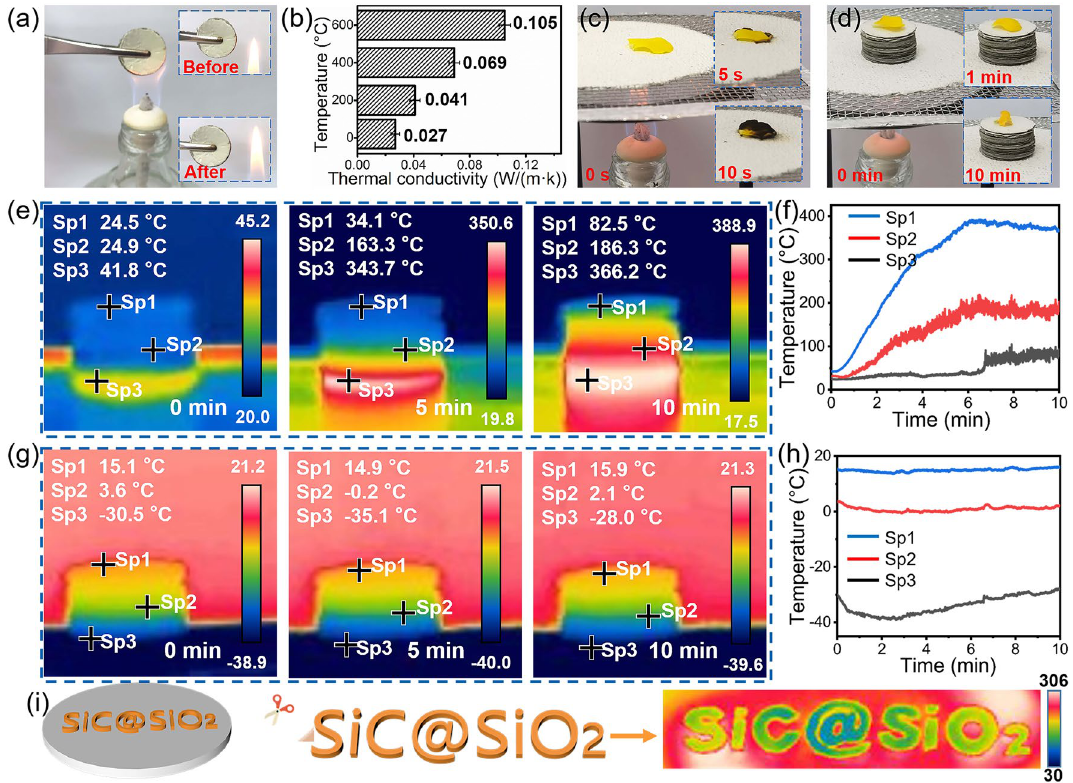
Fig. 6 Fire and high/low-temperature resistance and thermal insulation performance of the SiC@SiO 2 NFA. a Digital photographs of the SiC@ SiO 2 NFA exposed to the flame of an alcohol lamp. b Thermal conductivities of the SiC@SiO 2 NFA at various temperatures in an argon atmos- phere. c A flower placed onto the asbestos network and d a flower placed onto the SiC@SiO 2 NFA in a burner flame. Thermal images of the SiC NFAS recorded during e heating on a heated platform and g freezing on a refrigeration platform with the corresponding ( f and h ) temperature vs. time curves. i Schematic of the thermal insulation mechanism for the SiC@SiO 2